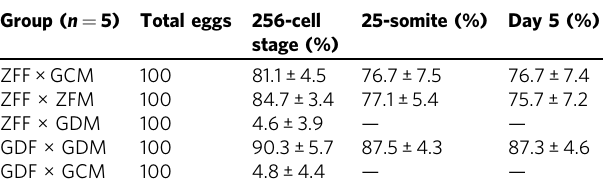
Table 3 Fertilization success with donor-derived sperm. Data represent mean ± SD, n = 5 biological replicates; (-) indicates no survival in the